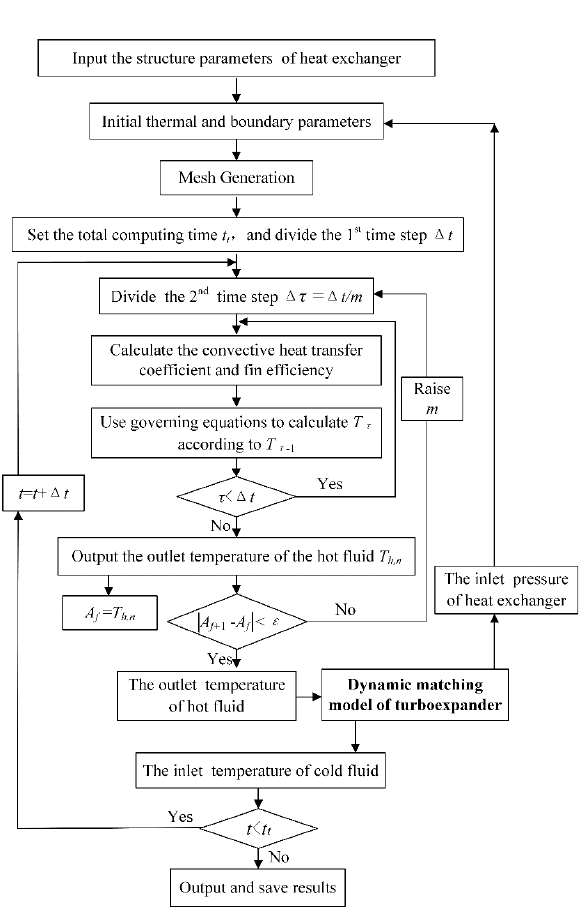
Figure 5. Flow chart of the cooling model [15].